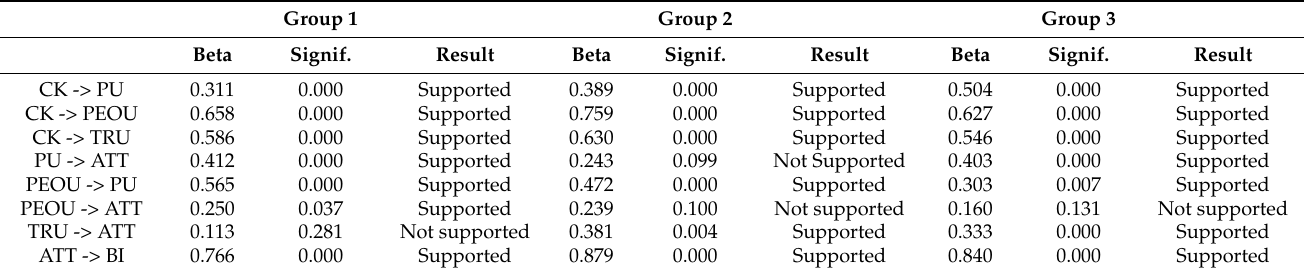
Table 10. Hypothesis testing of